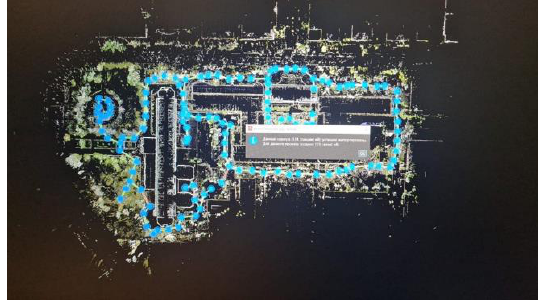
Figure 6. The process of registering a new project.